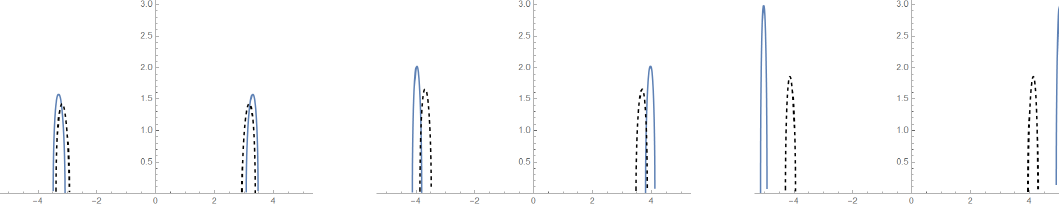
Figure 3 . Plots of the eigenvalue distributions of the pure potential matrix model (black and dashed) and the multi-trace matrix model (5.1) for values of r = {− 20 , − 27 , − 34 } and g = 0 . 5 . In all the cases we can see that the interaction spreads the eigenvalues further apart. The wider the dashed distribution, the stronger the repulsive interaction spreading the multi-trace